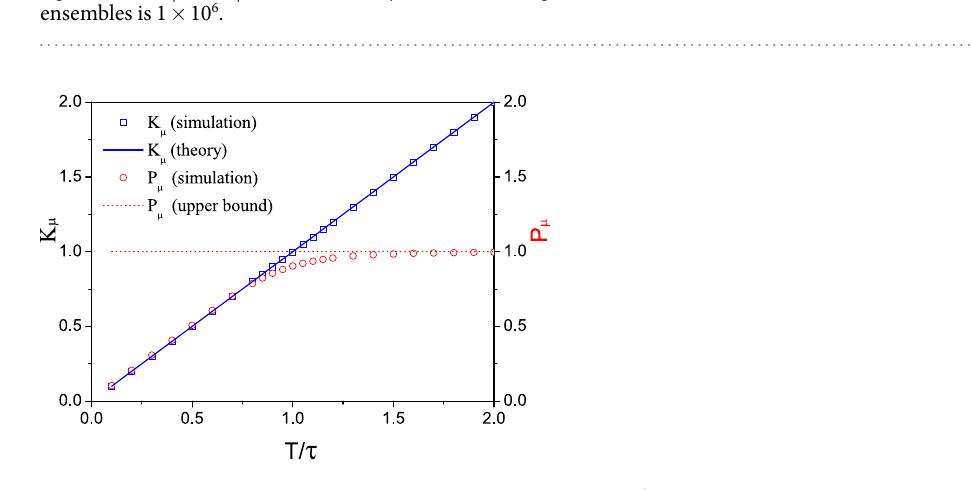
Figure 5. K μ , P μ as function of the scaled temperature T / τ . Here 10 6 ensembles are used and each ensemble of the system evolves 10 6 time steps. Here we set τ = 1, ε = 0.0001, and γ =